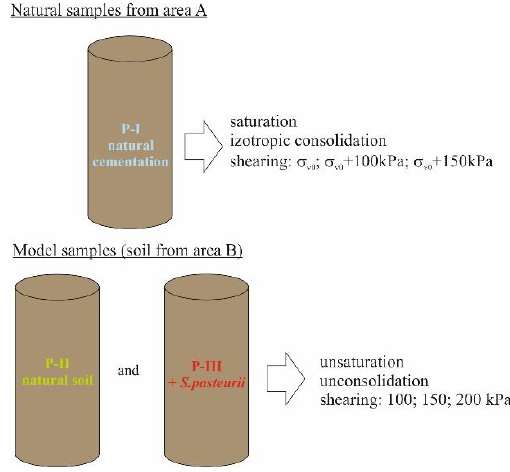
Figure 4. Procedure adopted for triaxial testing.